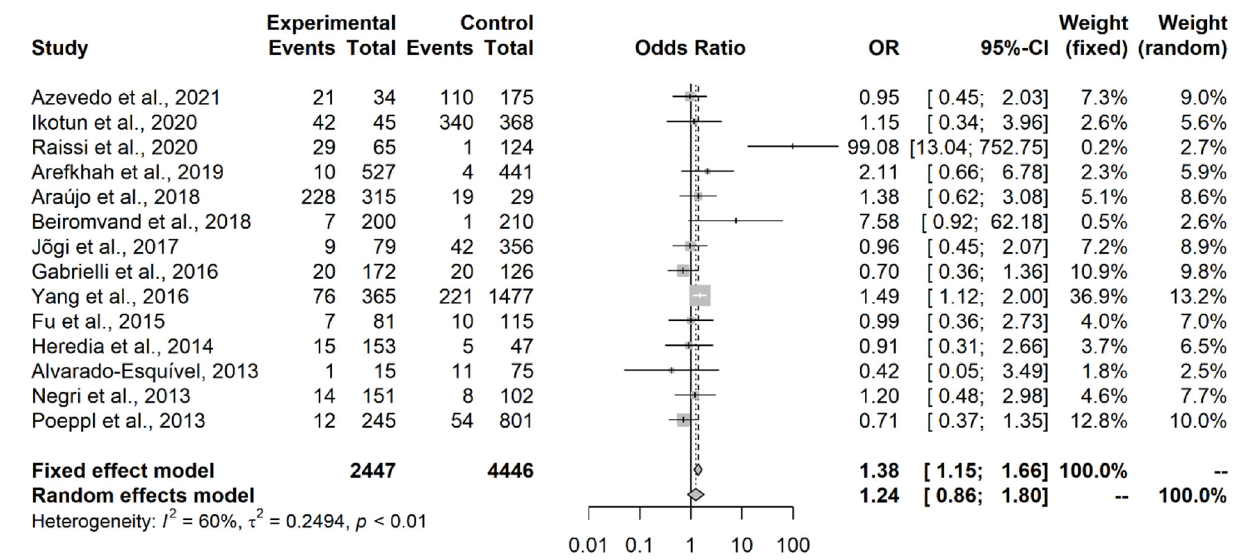
FIGURE 4 | Forest plot for assessment of odds-ratio of influence of contact with dogs in the frequency of anti- Toxocara antibodies in adult participants, according to selected articles used in the meta-analysis from 2009 to 2021.